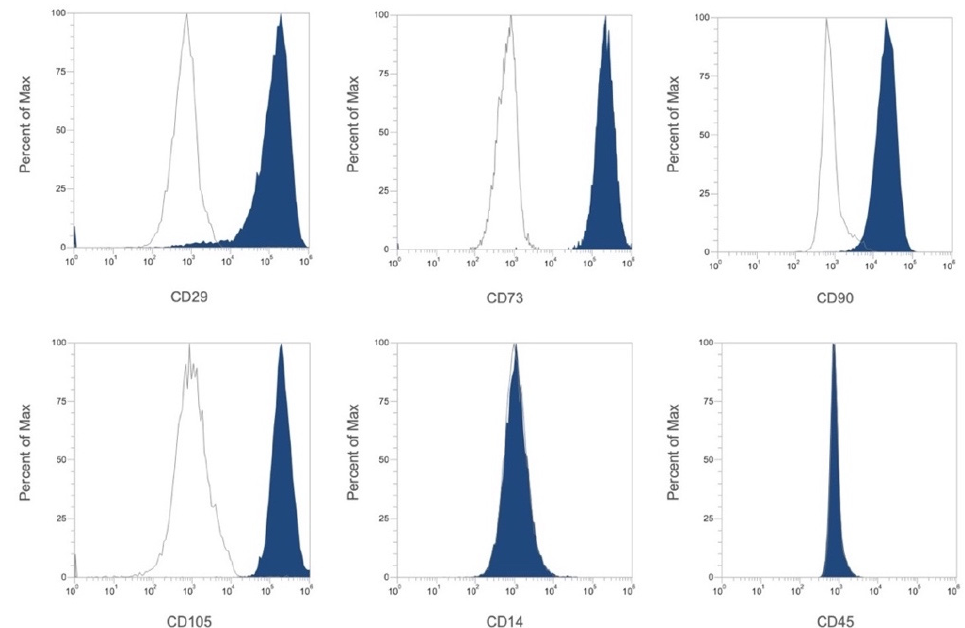
Figure 1. Characterization of cell surface markers in DPSCs at passage 3 by flow cytometry. The stem cells isolated from dental pulp are positive to CD29, CD73, CD90, and CD105 MSC-specific markers and negative to CD14 and CD45 hematopoietic markers. White negative, Blue positive.